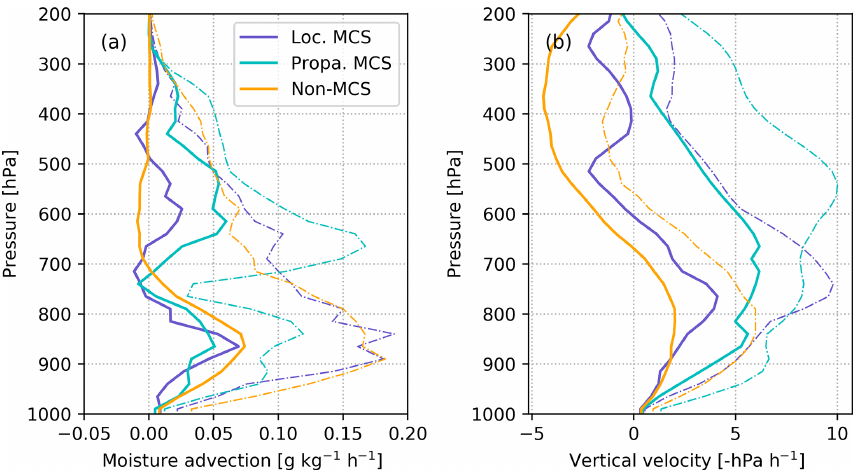
Figure 14. Variational forcing profiles at 12:00UTC for non-MCS, local MCS, and propagating MCS cases with rain rate less than 1.5mmh − 1 . Profiles correspond to the regime 4 conditions. Solid lines are median profile values and dashed lines are the 95th percentile